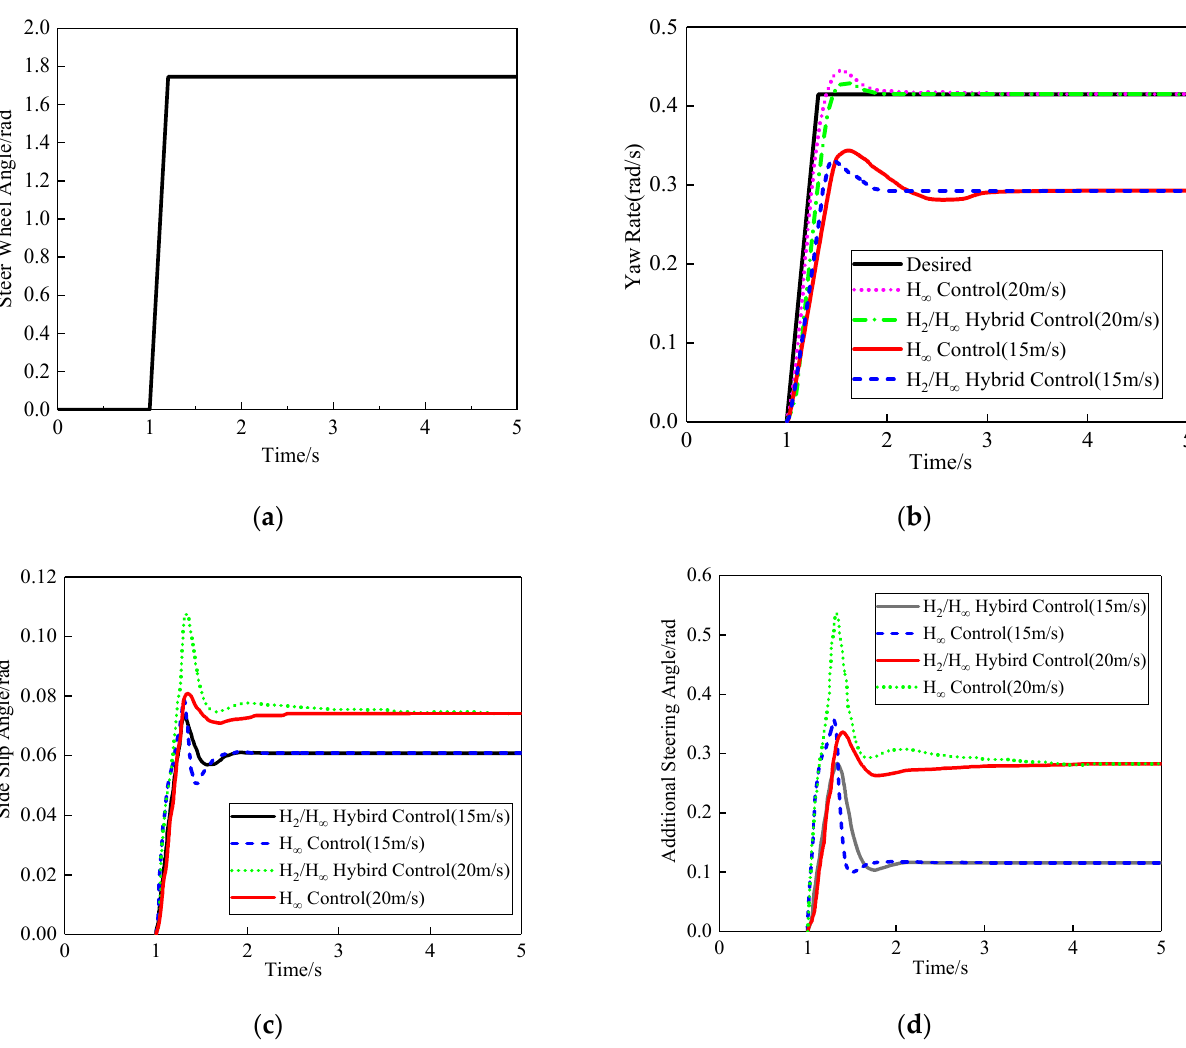
Figure 8. Step input simulation verification (when V x is 20 m/s and 15 m/s, and μ is 0.4). ( a ) Steering wheel angle; ( b ) yaw rate; ( c ) side slip angle; ( d ) additional steering angle.